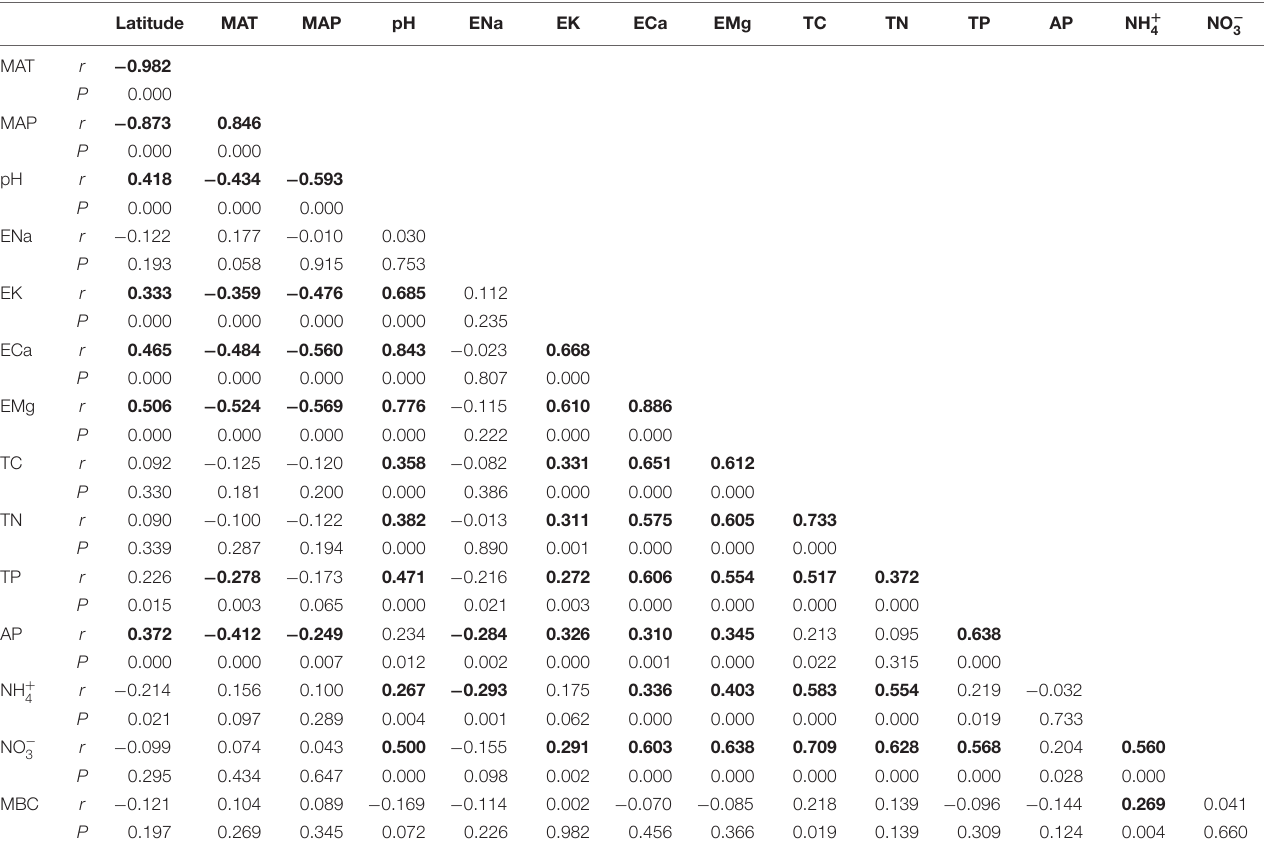
TABLE 1 | The correlation matrix between soil/site